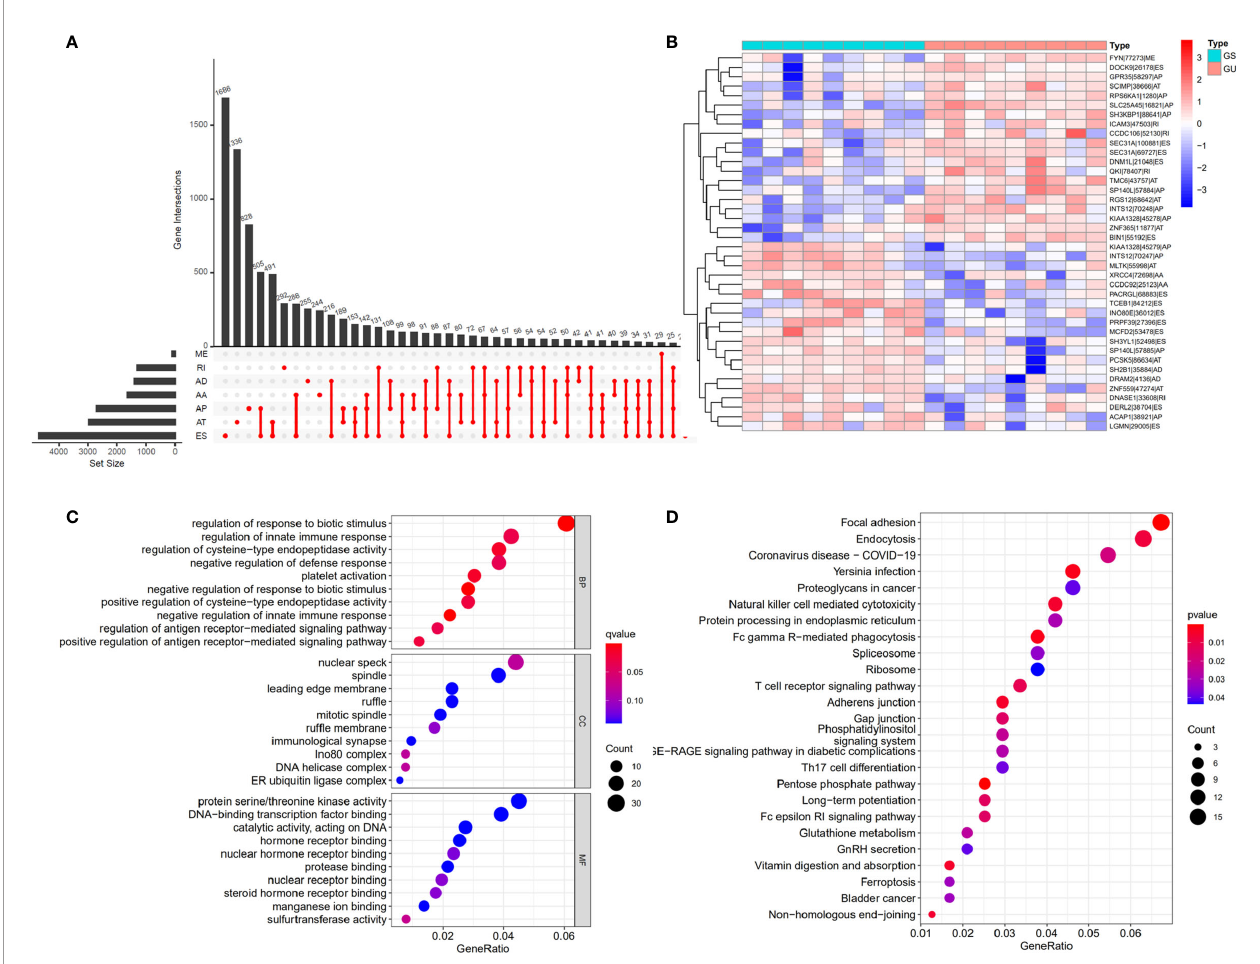
FIGURE 2 | Differential alternative splicing (AS) events between genomic stable (GS-like) and unstable (GU-like) patients. (A) AS events and related genes in cholangiocarcinoma patients. (B) Differential AS events between GU-like and GS-like groups. (C) Bubble graph showing GO analysis of differential AS events. (D) Bubble graph showing KEGG analysis of AS